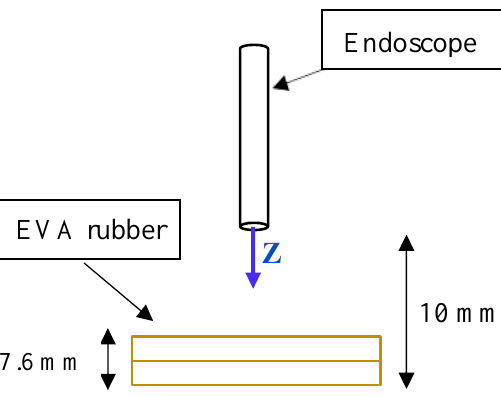
Figure 9. Scenario 2 schematic.